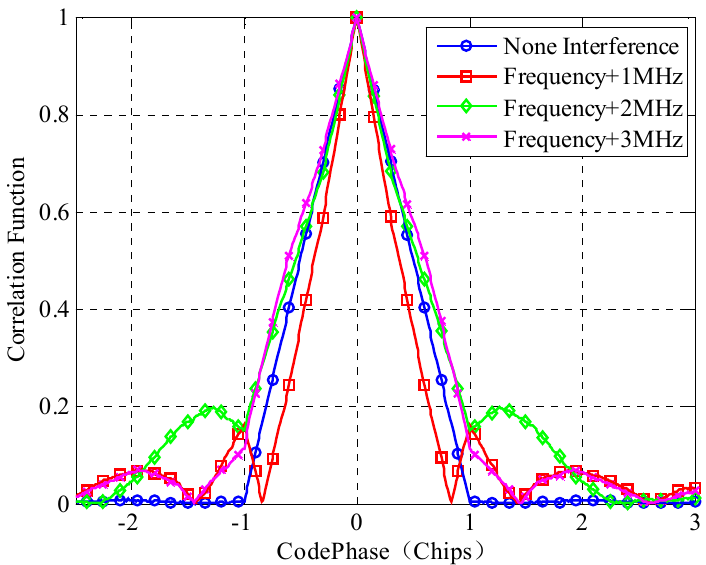
Figure 8. Influence of correlation function under different interference bandwidths.